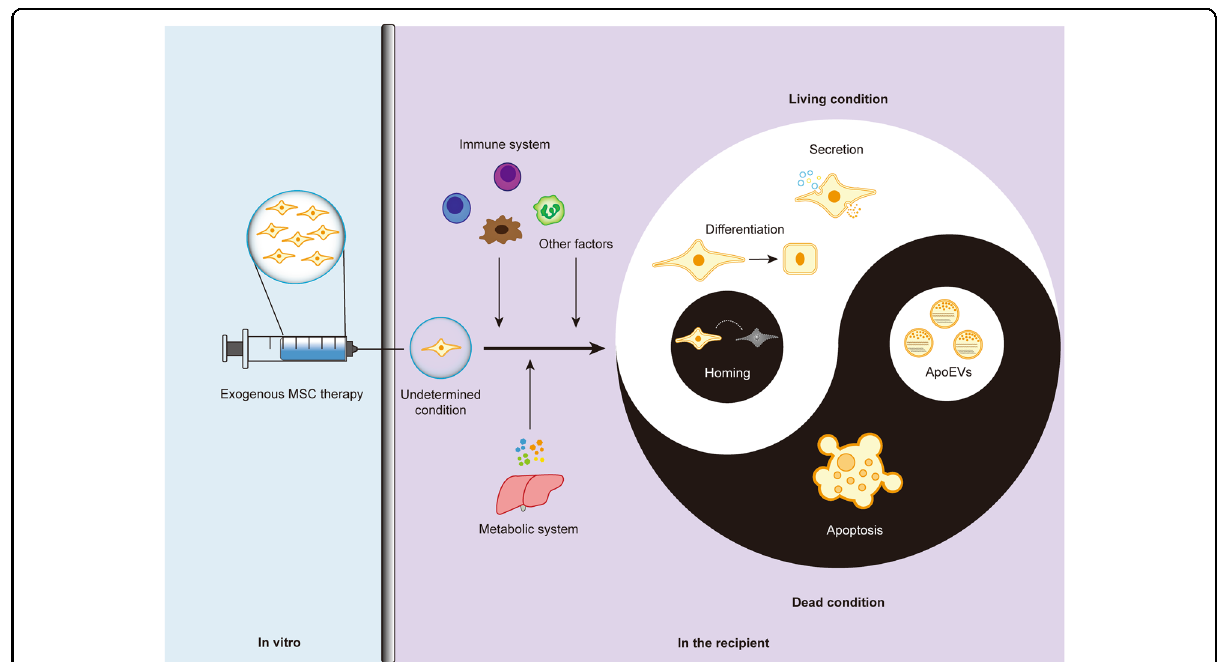
Fig. 1 Live-dead decision of MSCs in therapy. After infusion, exgenous MSCs in the undetermined condition confront with the stimuli of multiple factors inculding immunological, metabolic, and other cues. Subsequently, the MSCs can be alive to exert therapeutic effects based on differentiation and secretion, which also can undergo apoptosis to regulate immune responses. ApoEVs have been demonstrated to be a noval and potent therapeutic in translational medicine. The above condition of live-dead decision for infused MSCs based on current recognitions has emerged as a representative paradigm of